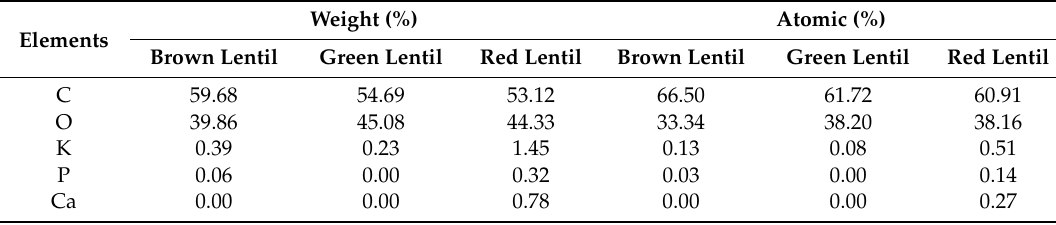
Table 2. Energy-dispersive X-ray spectroscopy analysis of the